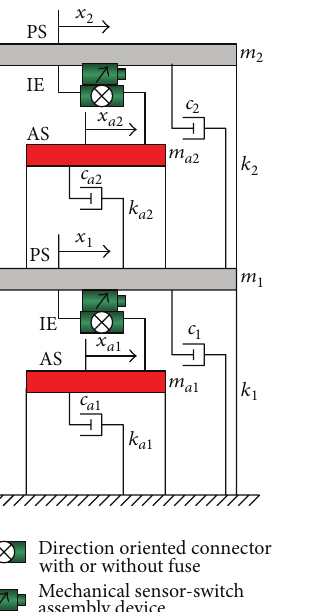
Figure 2: The systematic organization of ASHD as AIC [16].